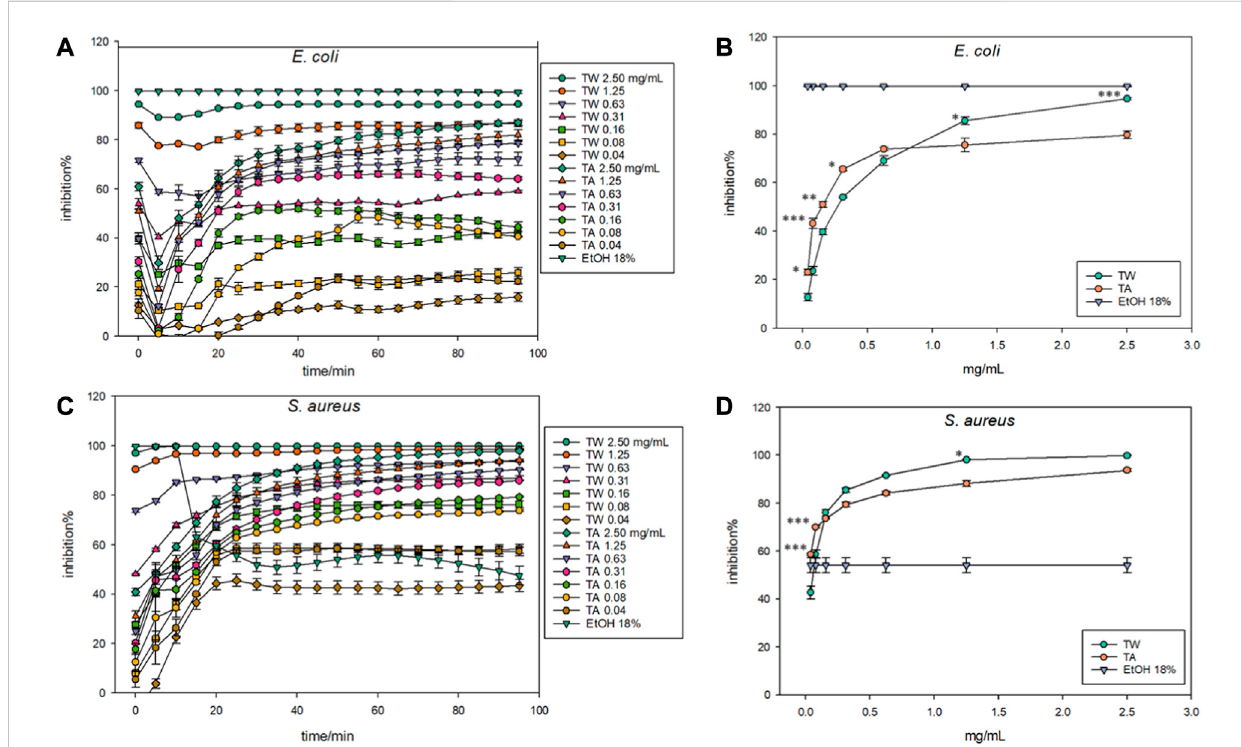
FIGURE 3 The bacterial biosensor luminescence production in inhibition percentages (inhibition%) in the presence of TW extract (TW) and tannic acid (TA) concentrations drawn against time in (A) ( E. coli ) and (C) ( S. aureus ) and drawn against the concentration in (B) ( E. coli ) and (D) ( S. aureus ), where the statistically signi fi cant differences between TW and TA concentrations are indicated with asterisks: * p ≤ 0.05, ** p ≤ 0.01, *** p ≤